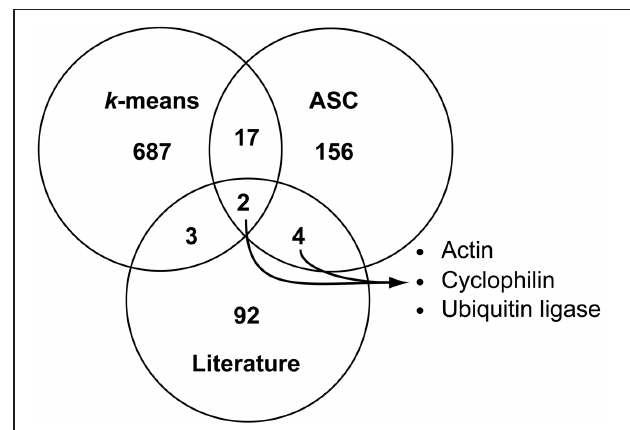
FIGURE 3 | Comparison of possible reference genes found with literature-based searches, k- means clustering, and ASC analysis of 1.25 fold change. Venn diagram analysis was used to compare genes identified as candidate reference genes through literature-based homolog searches (totaling 101 genes), with the k- means clustering method (genes in Cluster 9 and Cluster 14, totaling 709 genes), and with quantitative exclusion by ASC (based on genes demonstrating a 1.25 fold change with a post- p < 0 . 1, totaling 179 genes). The number of genes in each region is reported. The intersection of all ASC and literature-based searches yielded six total genes representing three different gene families: actin (NCBI: 7449411), cyclophilin (NCBI: 7445376), and ubiquitin ligase (NCBI: 7448637, 7450639, 7446724, and